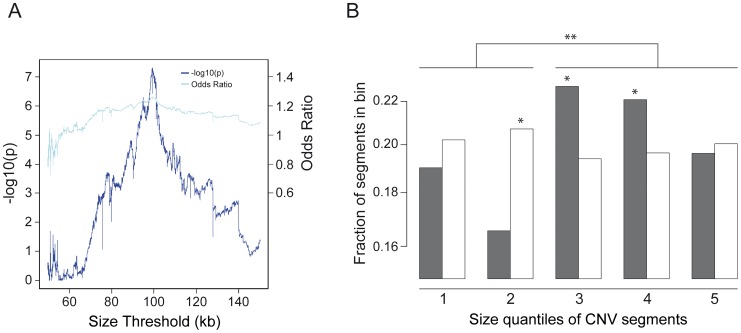
Higher incidence of CNVs with a length of above 100 kb in affected individuals.(A) Presentation of the Odds Ratio (light blue) and –log10(p-value) (dark blue) for determination of the size threshold of the number of CNVs in patients vs. controls. The Odds Ratio and the –log10(p-value) confirms a CNV size cut-off at 99.2 kb (OR 1.26 and p-value 4.98×10−8). (B) Fraction of copy numbers segments in cases (grey) vs. control (white) quintiles (* p<0.005). Quintile borders were Q1: 68.3 kb, Q2: 99.3 kb, Q3 149.6 kb, Q4 298.1 kb, and Q5: 72,571.3 kb. The y axis presents the fraction of CNVs inside the corresponding quintile bin. Significance levels are calculated using Fisher's exact test. The figure shows a shift towards segments above 100 kb in patients (** p-value 1.188×10−7).